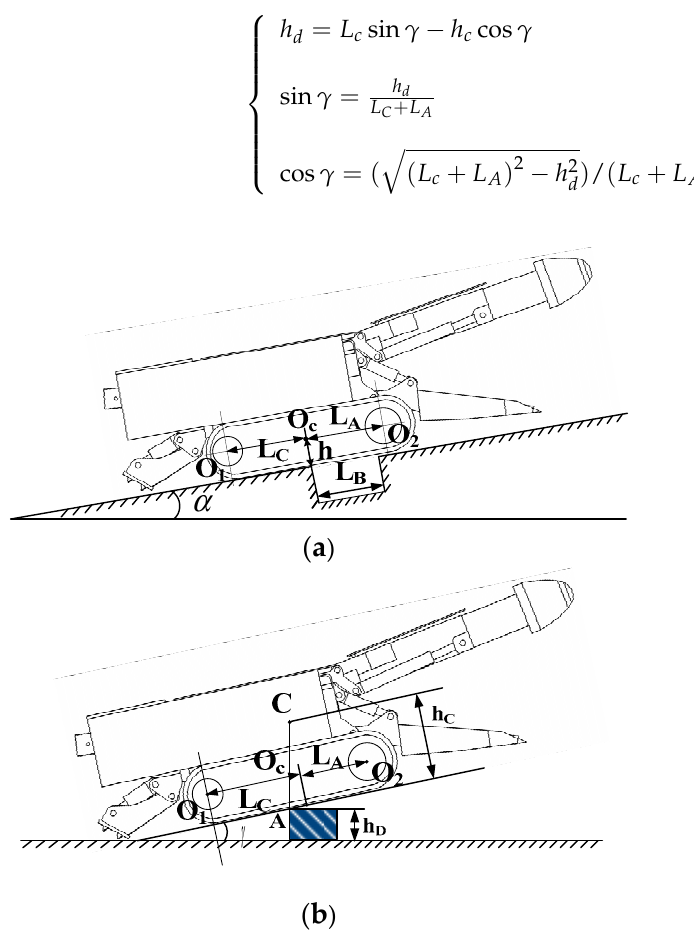
Figure 4. Analysis of roadheader’s driving performance, ( a ) Analysis of ditching capacity, ( b ) Analysis of obstacle crossing ability.